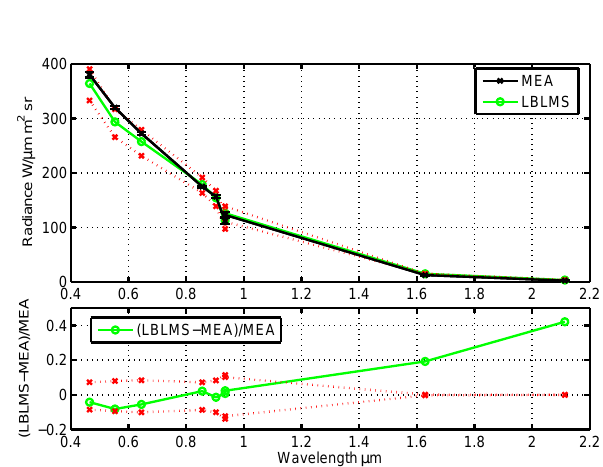
Fig. 25. Same as Fig. 23 but for Area Ci3.